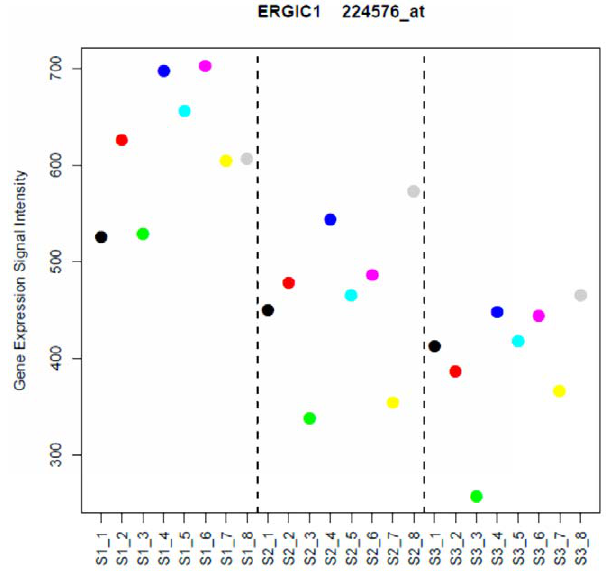
Figure 4. ERGIC1 gene expression profiles across the series of arrays. In x-axis, the samples were arranged in accordance with the array Series 1–3 from the left to the right. Colours represent blood samples collected from the same volunteers. The y-axis indicates the gene expression signal intensity.